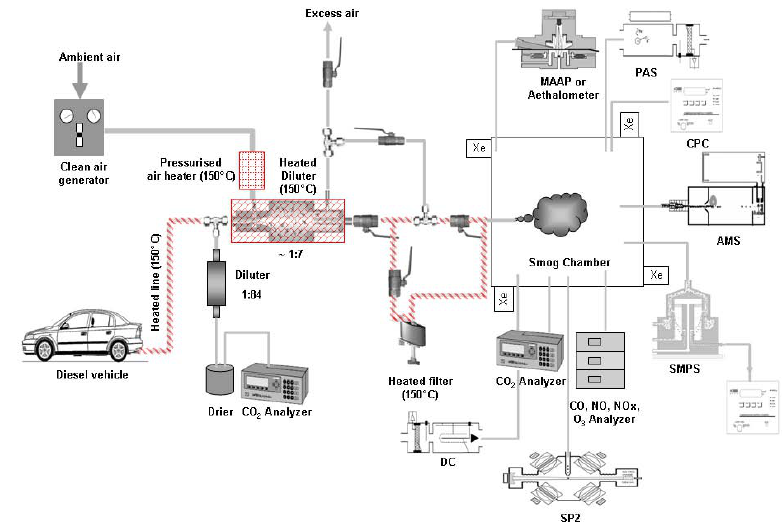
Fig. 1. Schematic representation of the sampling line, the smog chamber and the measurement setup of the smog chamber. was maintained at 150 ◦ C to avoid condensation of